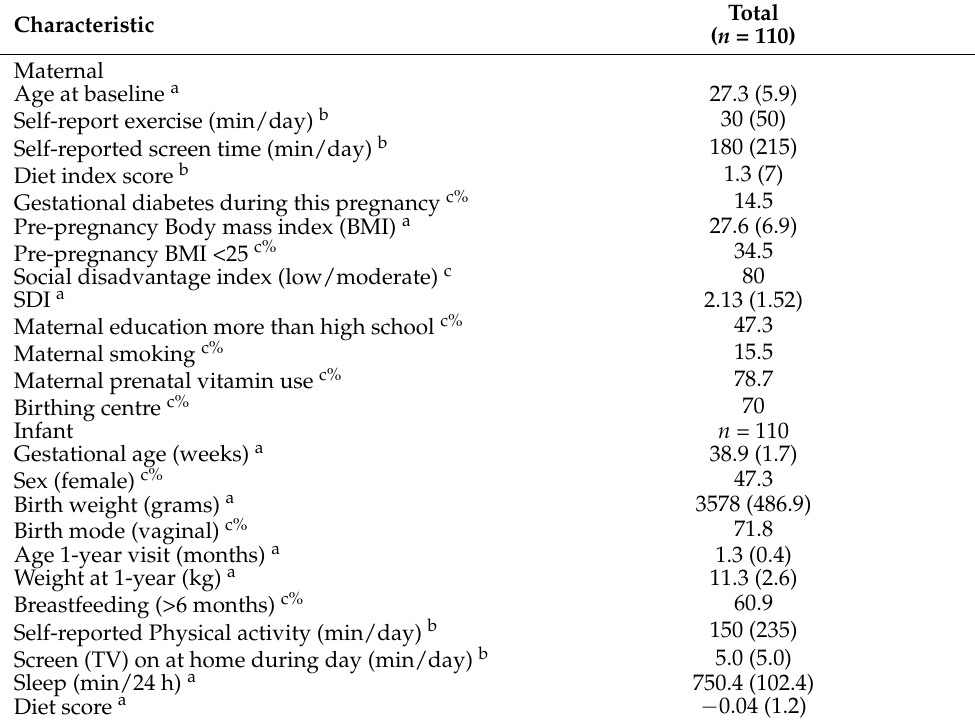
Table 1. Maternal characteristics at baseline and infants at age